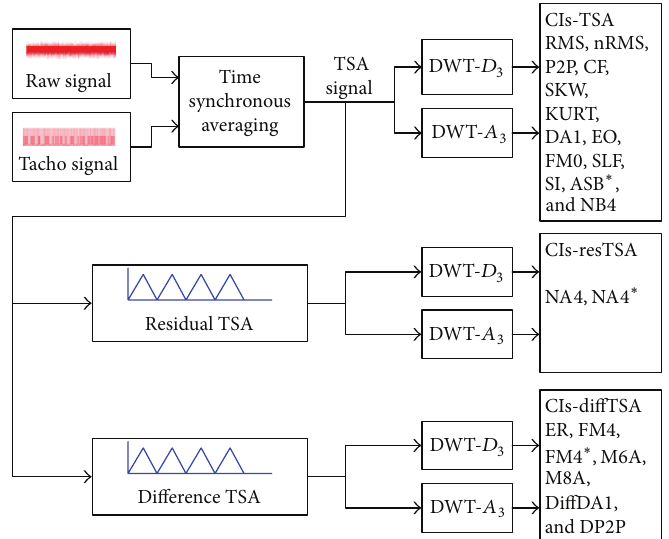
Figure 2: Processing flow chart for feature extraction methods for vibration analysis.